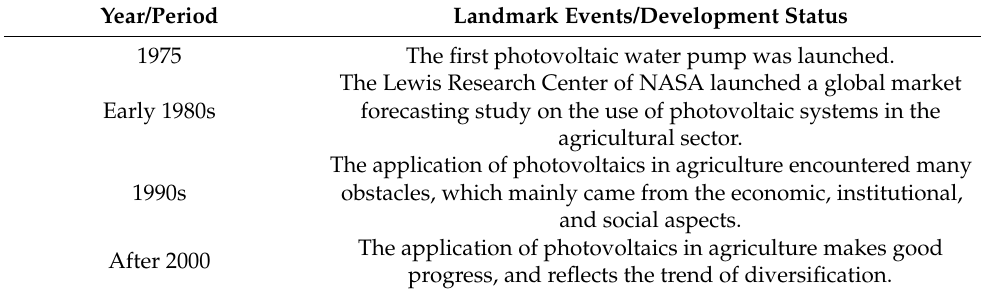
Table 1. Development history of photovoltaics application in agriculture.